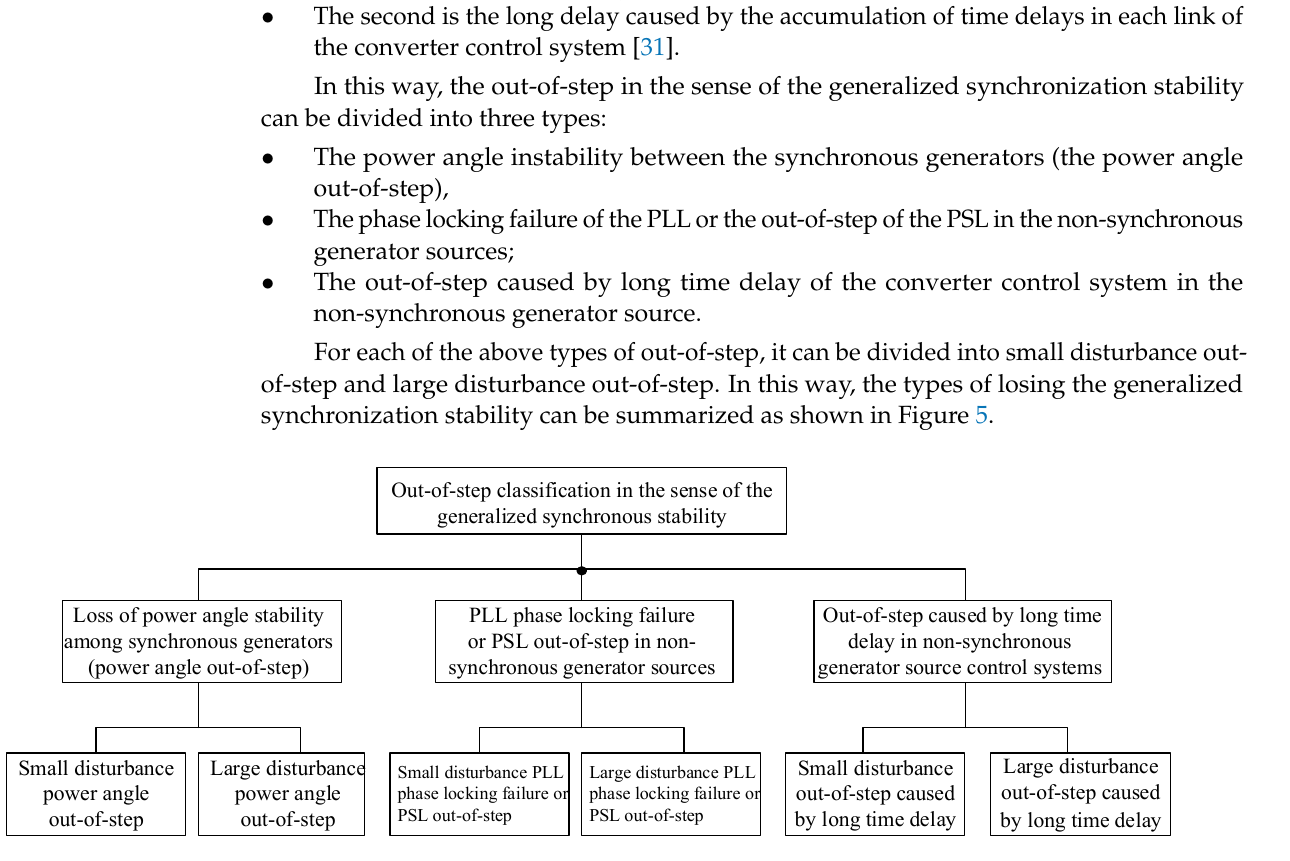
Figure 6. Relationship between the power angle stability and the generalized synchronization sta- bility. Example to Illustrate the Behaviour under PLL Phase Locking Failure The study system consists of one generator and one inverter station, supplying power to the load, as shown in Figure 7 [16]. In Figure 7, jx t represents the equivalent impedance of the generator step-up transformer, ( r r + jx r ) represents the line impedance from the PCC of the inverter station to the load; i s and u s are the current and voltage at PCC respectively. Assuming that the generator capacity is 270 MVA; the load active power is 400 MW under the rated voltage with the power factor of 0.95; the power supply proportion of the in- verter station is 40%; the inverter station adopts the grid following control and operates